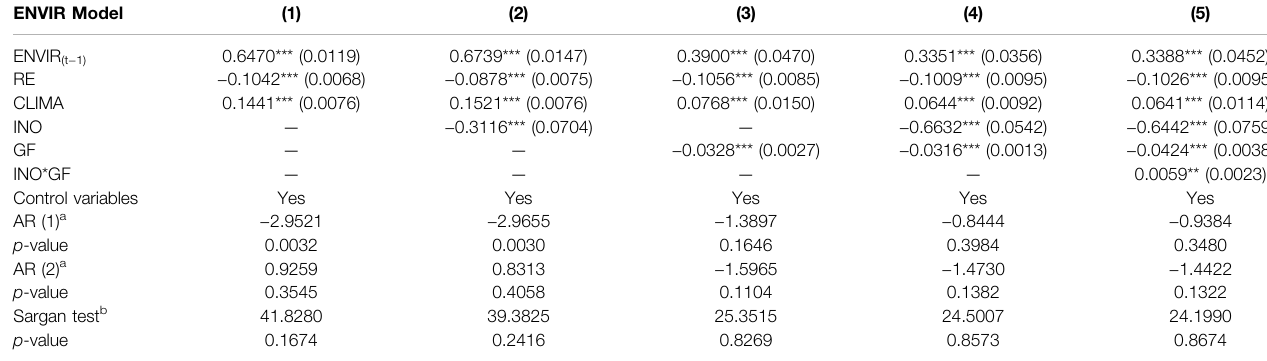
TABLE 5 | Environmental pollution model.